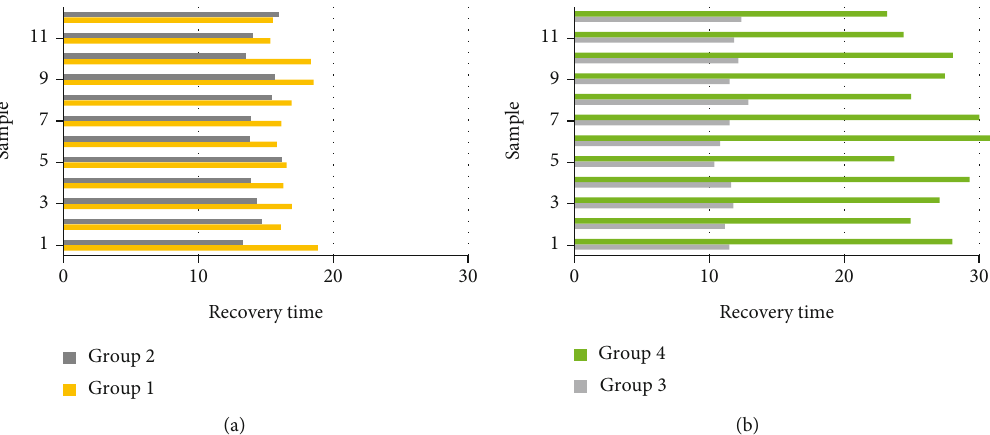
Figure 10: Treatment recovery time for each group. (a) The treatment recovery time of patients in group 1 and group 2. (b) The treatment recovery time of patients in group 3 and group